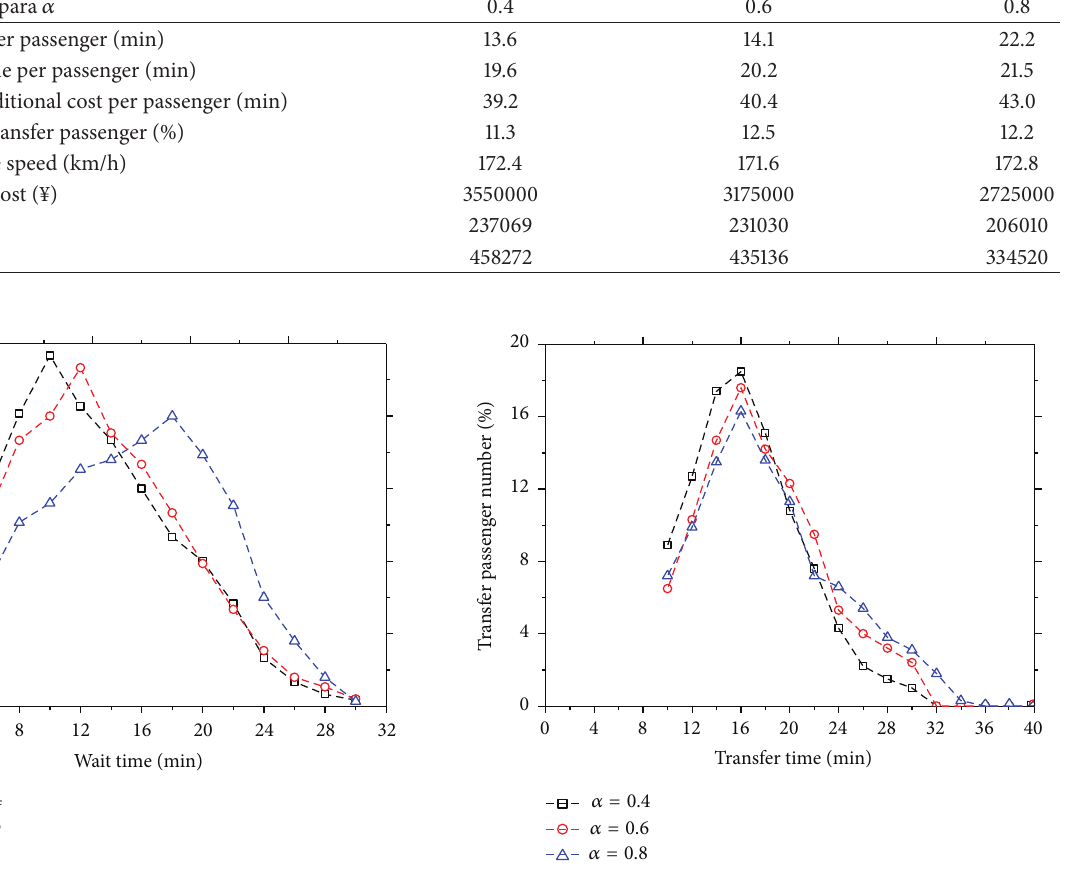
Figure 2: Distribution of passenger wait time. Figure 3: Distribution of passenger transfer